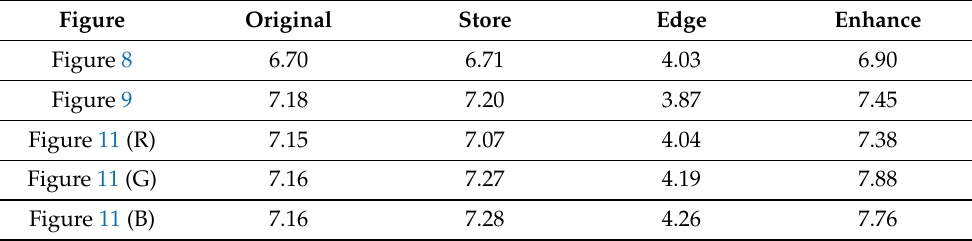
Table 4. Calculated values of entropy of the images. The results for the color image show the three color planes separately.